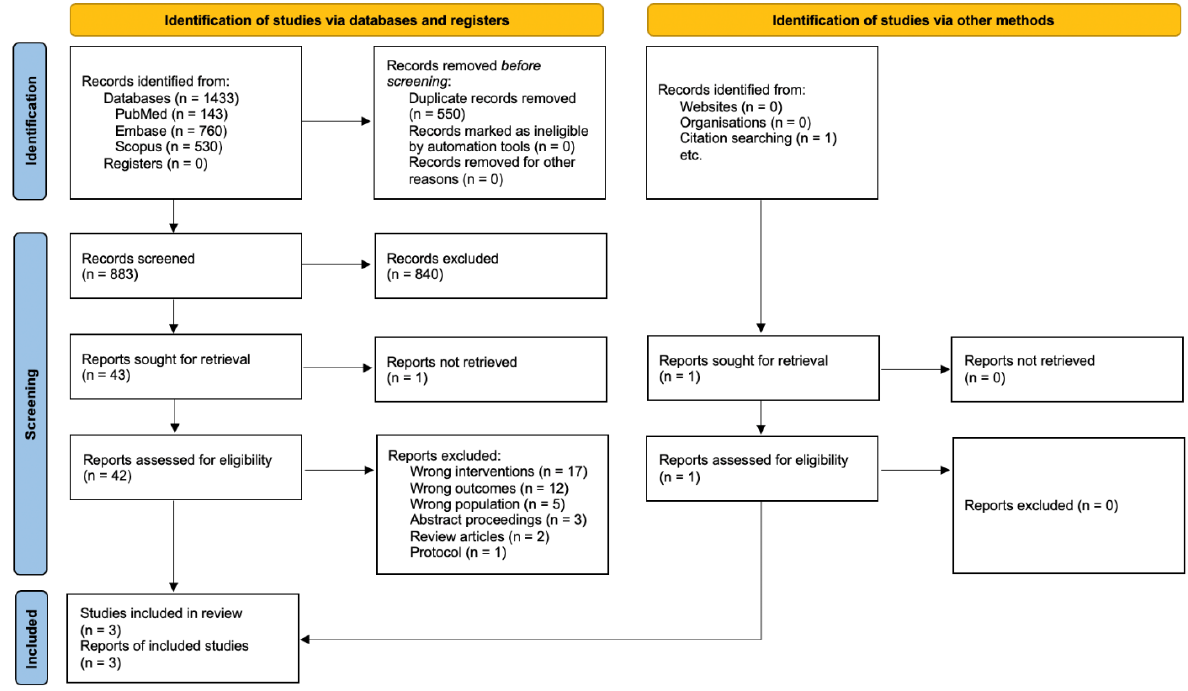
Figure 1. The PRISMA flow diagram.